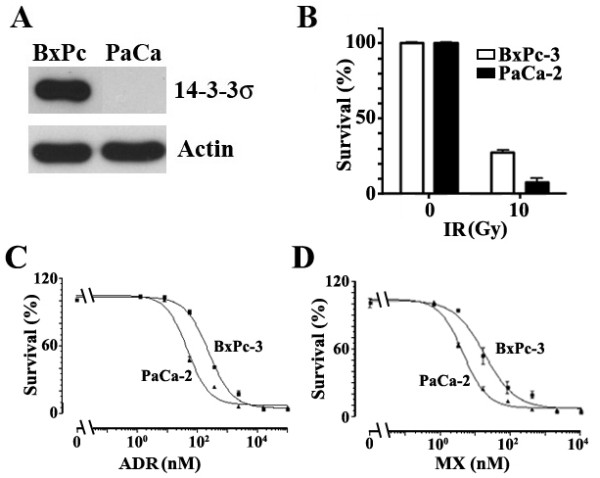
Relationship between 14-3-3σ expression and drug resistance of pancreatic cancer cell lines. A, Expression level of 14-3-3σ in BxPc-3 and MiaPaCa-2 cells. Lysates from BxPc-3 or MiaPaCa-2 cells were prepared for Western blot analyses of 14-3-3σ and actin as a loading control. B, C, and D, Correlation of 14-3-3σ expression and treatment resistance. The effect of γ-irradiation (B) and anticancer drugs Adriamycin (C) and mitoxantrone (D) on the survival of BxPc-3 and MiaPaCa-2 cells was determined using SRB assay. The survival following treatments was normalized to the control without irradiation or drug treatment.